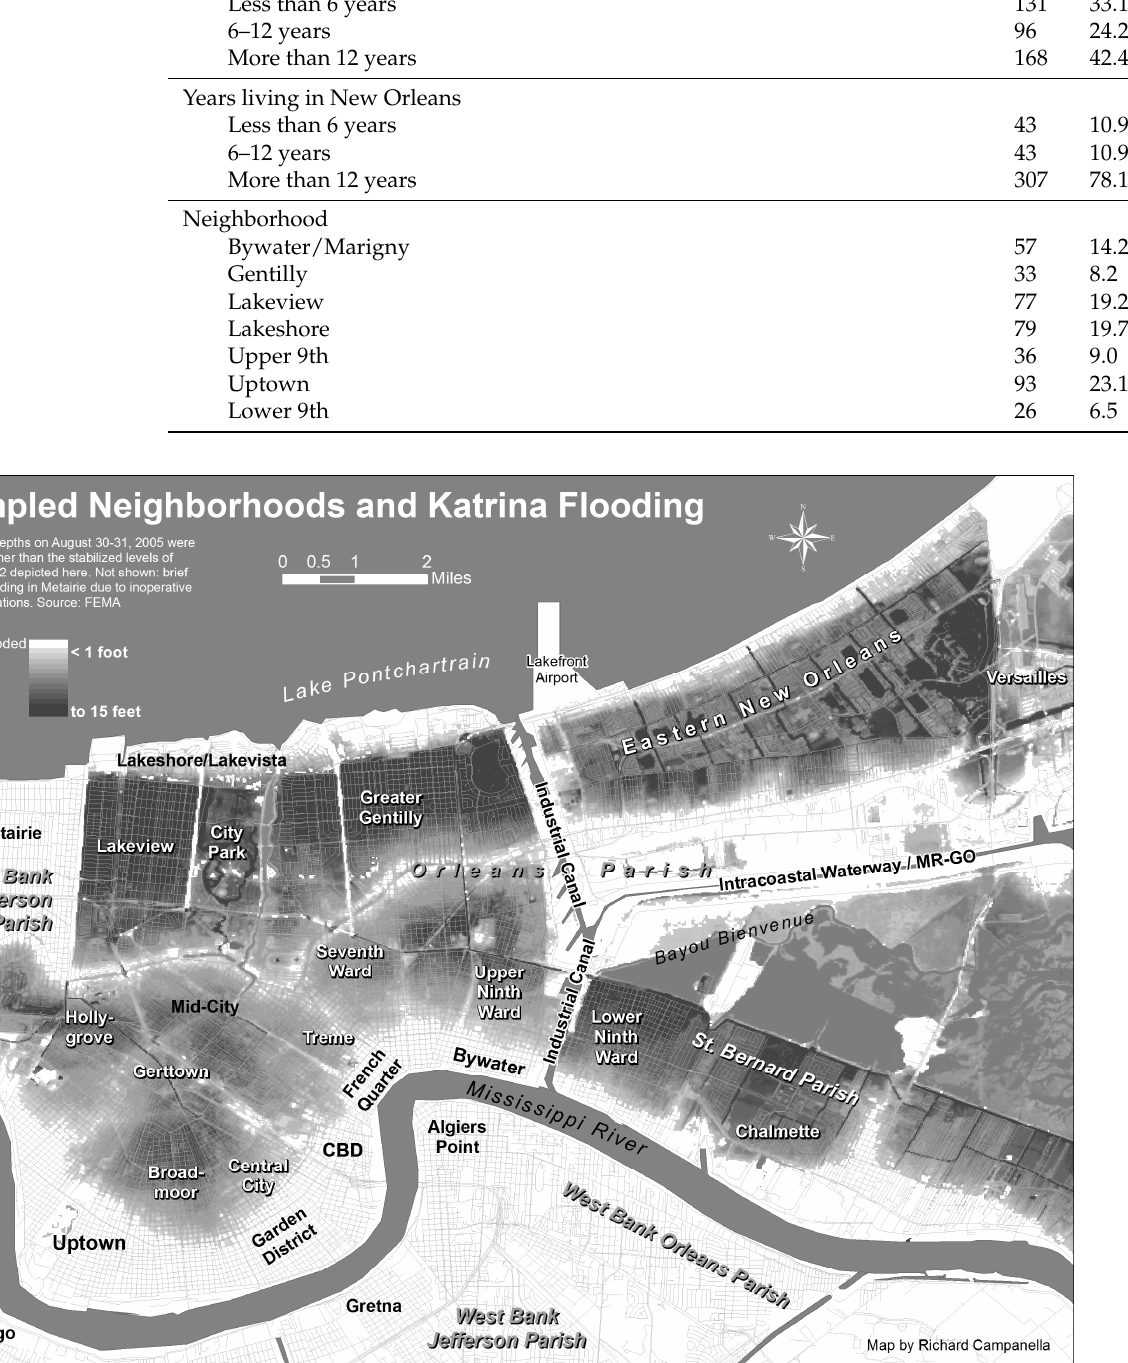
Table 1. Characteristics of Survey Respondents. Variable ( N = 401)